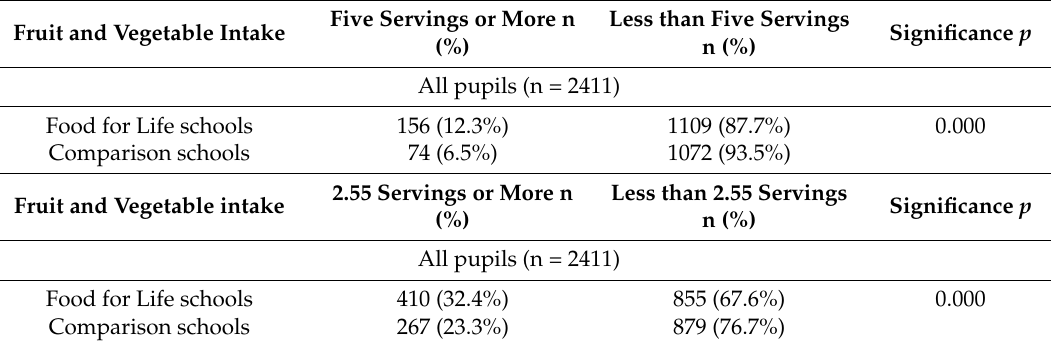
Table 6. Numbers of pupils consuming five or more servings and 2.55 or more of fruit and vegetables according to school engagement with Food for